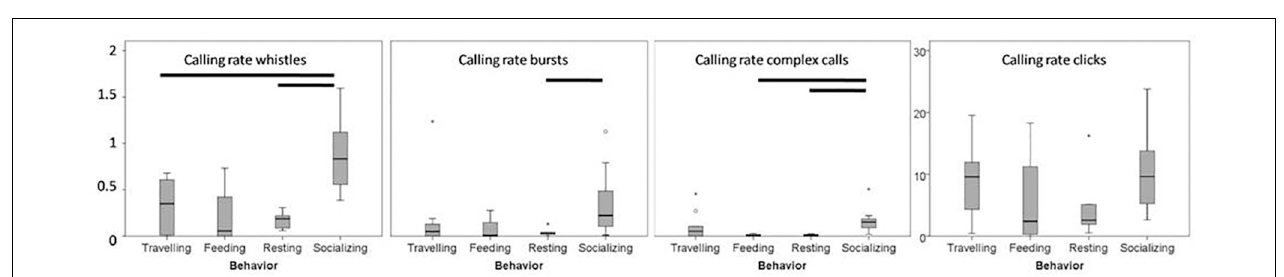
FIGURE 3 | Spectrogram (resolution of 1024 Fast Fourier Transform size and a Blackmann-Harris window) and waveform (graph energy vs. time) of a chorusing event made up of two overlapped complex calls, both combination of whistle and click train. Both signals were also independently detected during the recording.